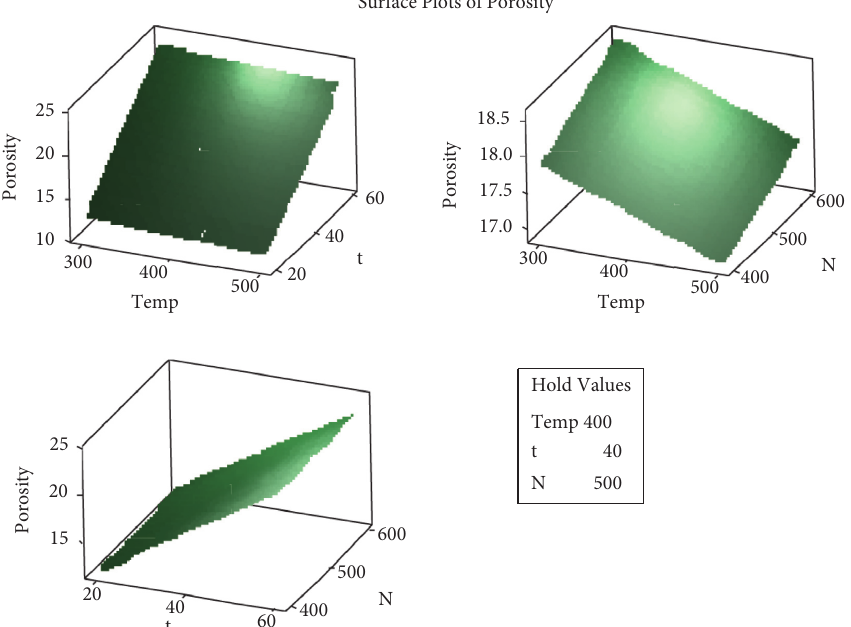
Figure 5: Comparison of surface plots for porosity (temp: temperature in ° C; t : time in sec; N : stir speed in